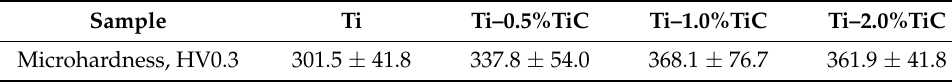
Table 3. Microhardness results of obtained composites.